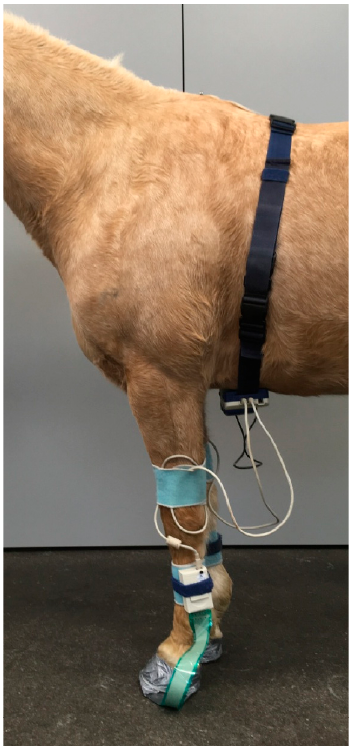
Figure 1. Horse equipped with the Hoof™ System.